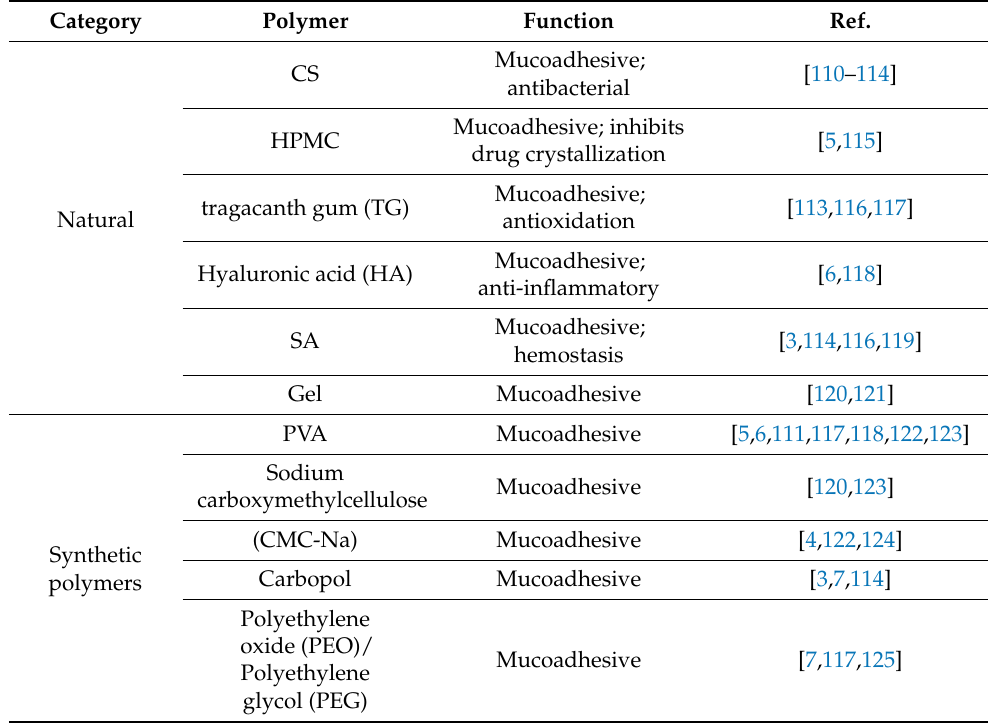
Table 2. Polymers for oral mucosal adhesion. Category Polymer